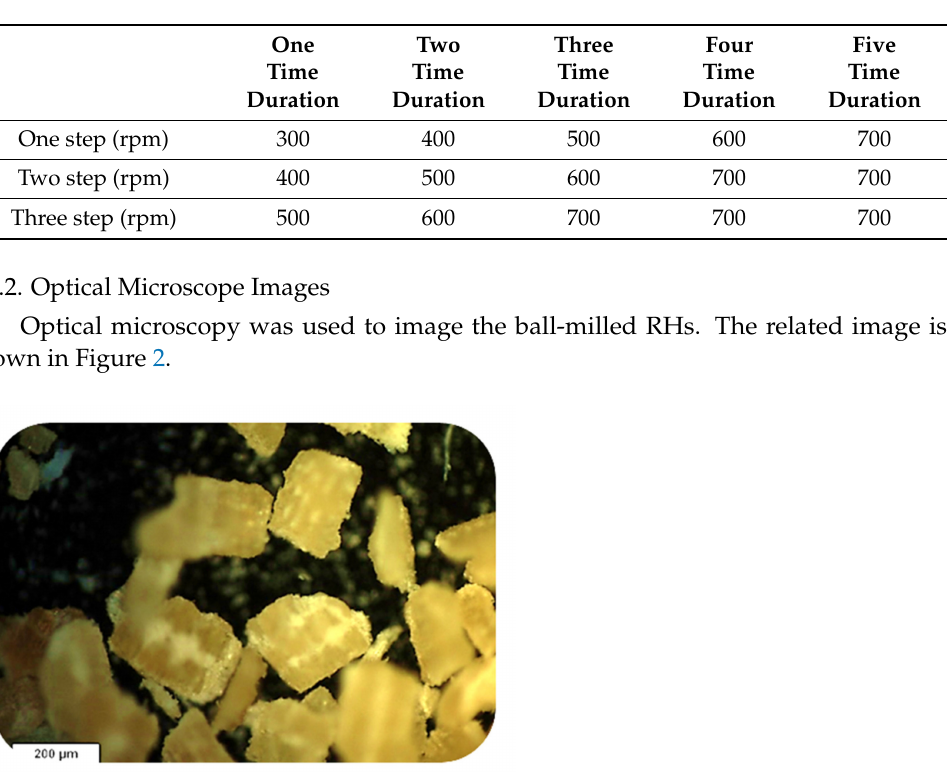
Table 1. Ball mill condition.